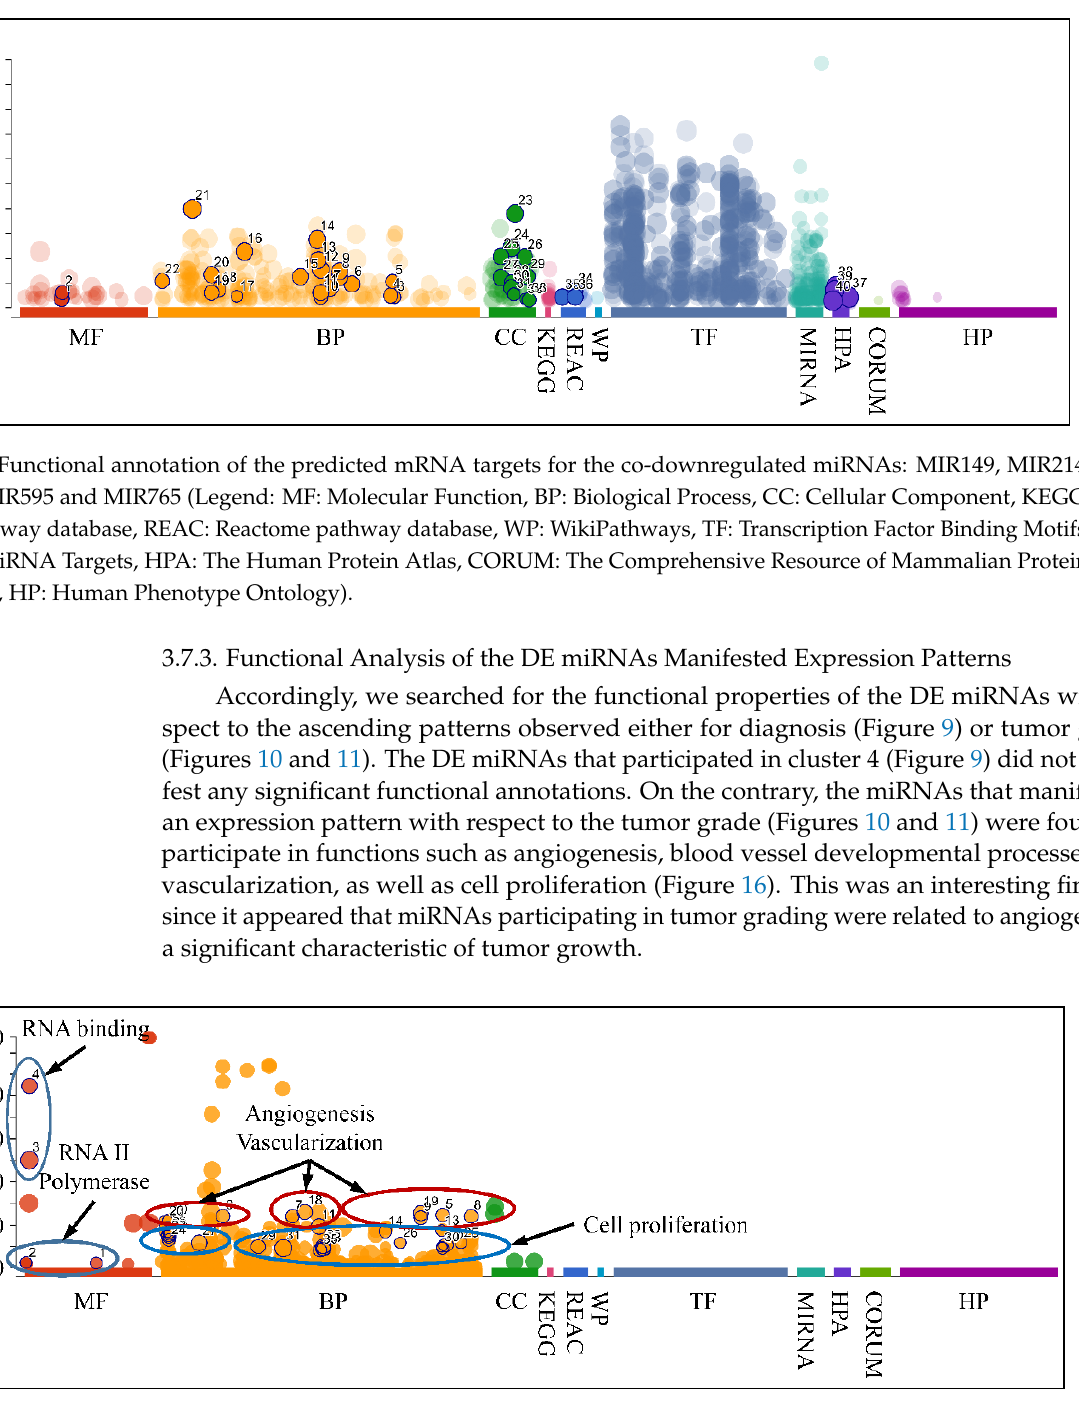
Figure 16. Functional annotation of miRNAs found to manifest an expressional pattern with respect to the tumor grade. (Legend: MF: Molecular Function, BP: Biological Process, CC: Cellular Component, KEGG: KEGG pathway database, REAC: Reactome pathway database, WP: WikiPathways, TF: Transcription Factor Binding Motifs, MIRNA: MiRNA Targets, HPA: The Human Protein Atlas, CORUM: The Comprehensive Resource of Mammalian Protein Complexes, HP: Human Phenotype Ontology).